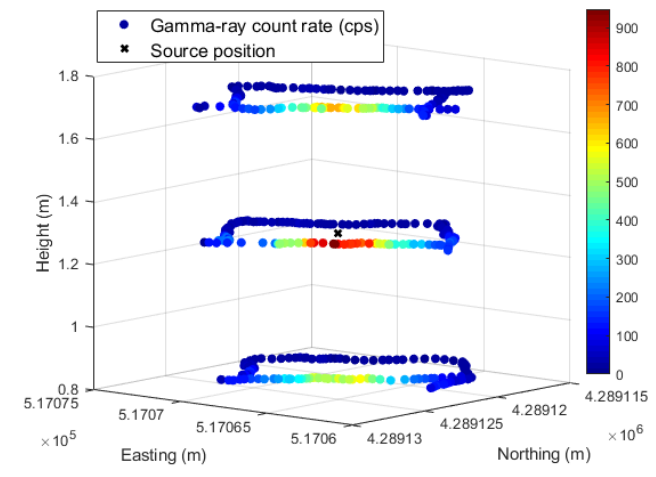
Figure 29. 3D view of the EJ-200 scintillator gamma-ray count rate (cps) measurements considering the Troxler equipment (collimated 215 MBq 137 Cs source—first notch after the safe position) in the center of the container. The true position of the Troxler is indicated by a